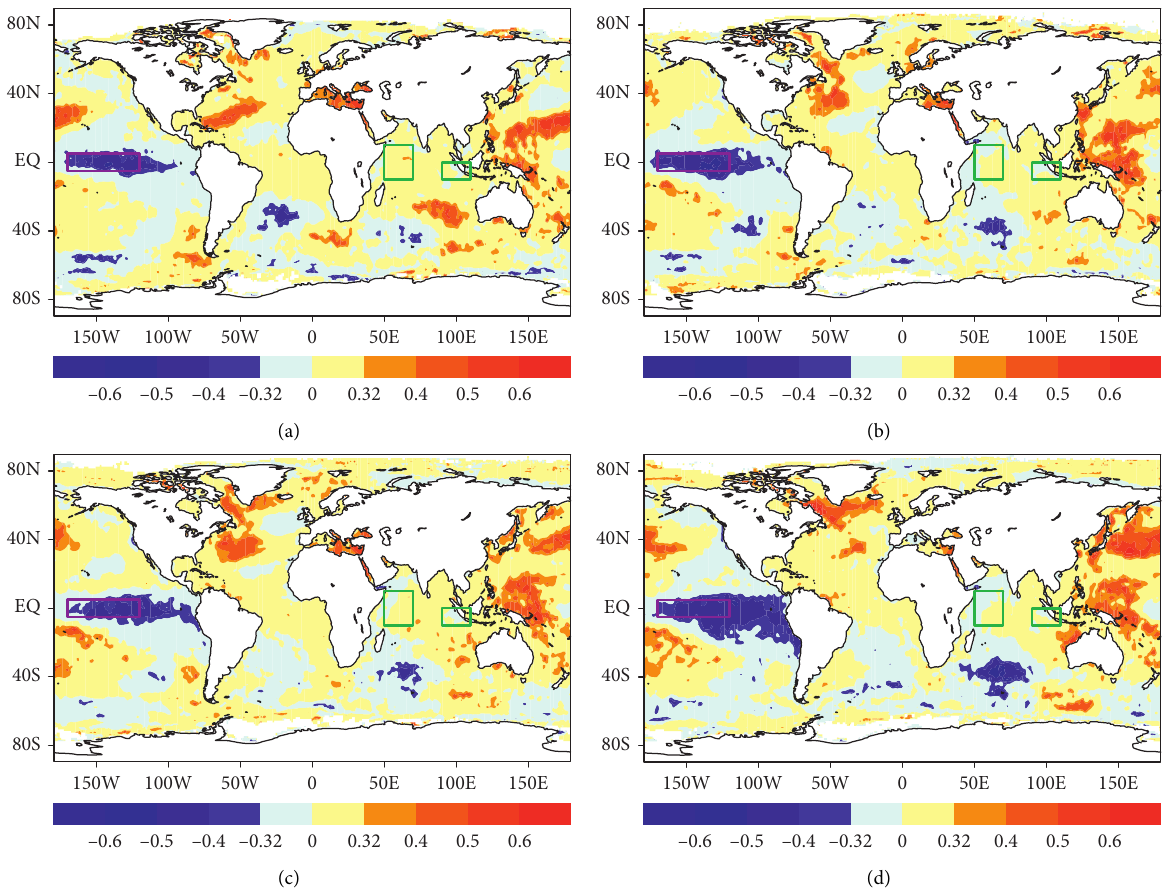
Figure 7: Correlation coefficients between the JJAS region rainfall and global SSTin (a) June, (b) July, (c) August, and (d) September. Areas with 95% confidence level are shown in dark shades. Purple box marks Nin ̃ o3.4 region and green boxes are western IO and eastern IO,